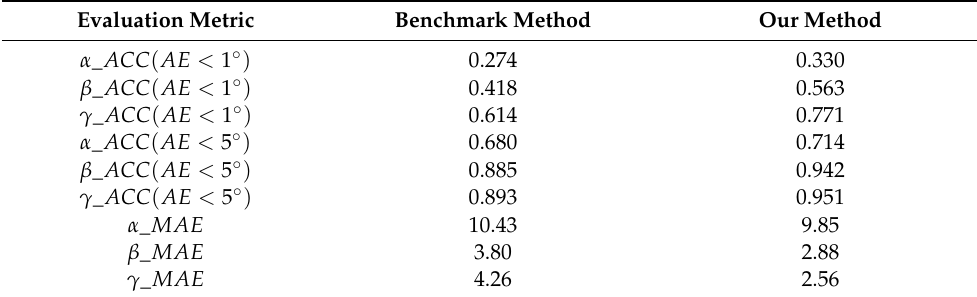
Table 9. Results of the comparison on the BUAA-SID-POSE 1.0